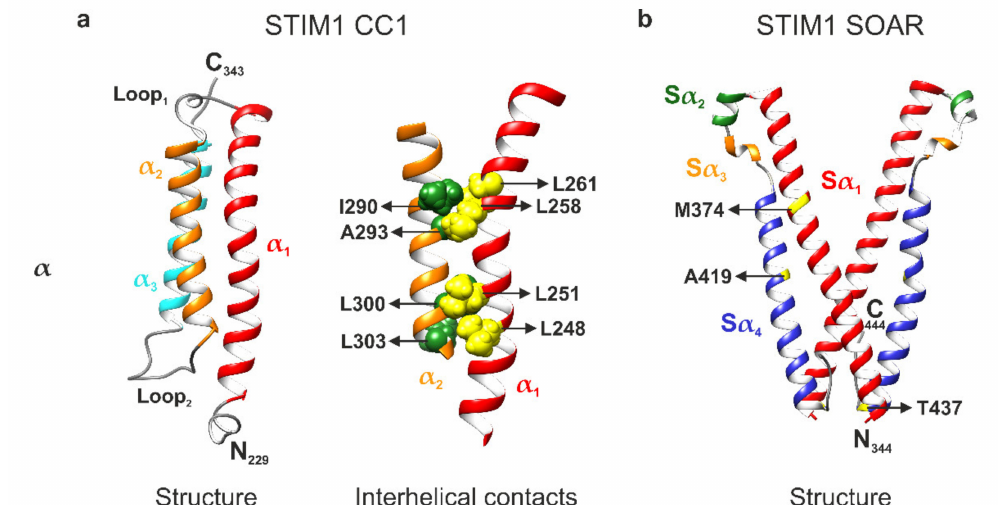
Figure 2. Structural resolutions of the stromal interaction molecule 1 (STIM1) C-terminus. ( a ) Left: nuclear magnetic resonance (NMR) structure of the STIM1 coiled coil 1 (CC1) domain monomer (PDB: 6YEL). The α 1, α 2, and α 3 helices form a three-helix bundle arranged in an antiparallel fashion that is connected by two flexible loops. Right: interhelical contacts between the α 1 and α 2 helices. The interacting residues of α 1 (L248, L251, L258, and L261; colored in yellow) and α 2 (I290, A293, L300, and L303; colored in green) are shown in space-filling representation. ( b ) X-ray crystallography structure of the STIM-Orai-activating region (SOAR) dimer (PDB: 3TEQ). The domain is comprised of four helices named S α 1 (corresponding to CC2), S α 2, S α 3, and S α 4 (corresponding to CC3) and shows an R-shape created by the antiparallel orientation of S α 1 and S α 4. The crystal structure contains several point mutations (L374M, V419A, and C437T) whose positions are indicated. Molecular graphics were created with UCSF Chimera (v1.14)